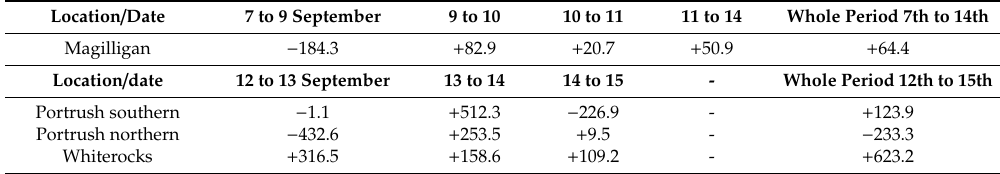
Figure 5. ( a ) Profile 2 evolution and ( b ) 3D morphological changes at Magilligan. Table 2. Volumetric variation (m 3 ) between surveys and at the end of the monitoring